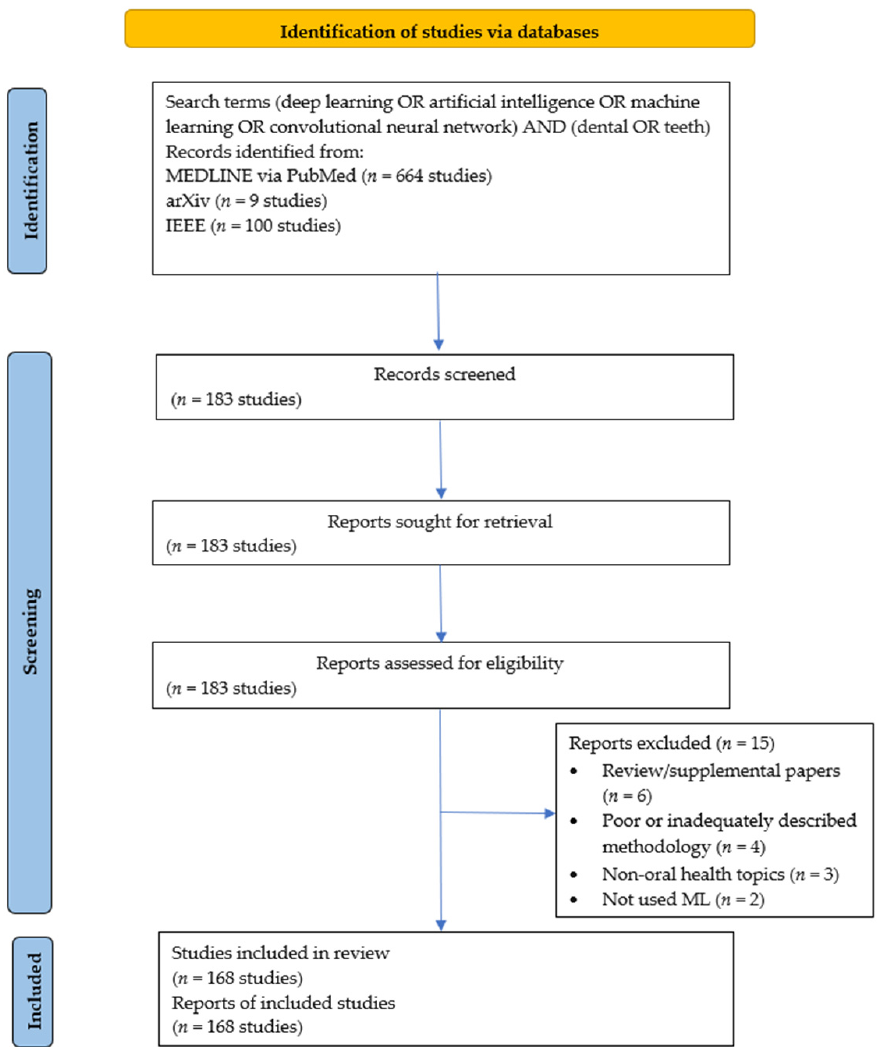
Figure 1. PRISMA study flow diagram.